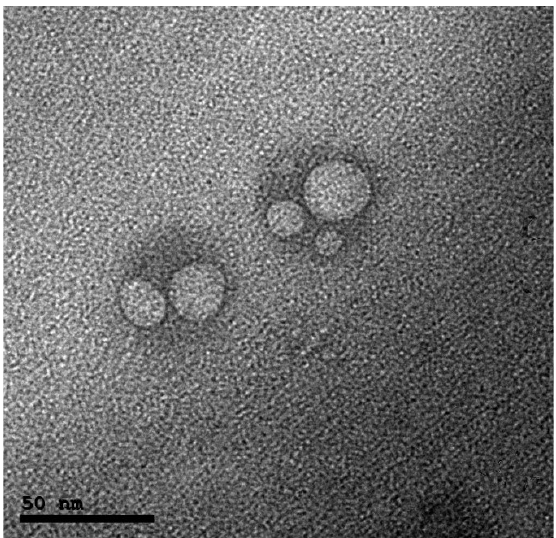
Figure 1. Transmission electron microscope (TEM) images of the carvedilol leciplex (F2).